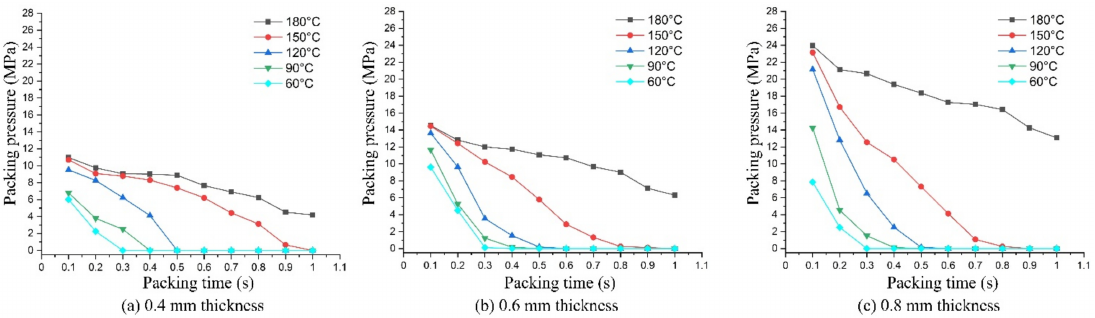
Figure 18. Packing pressure at the center point (F) of obtained products with PA6 material with part thickness of 0.4 mm ( a ), 0.6 mm ( b ) and 0.8 mm ( c